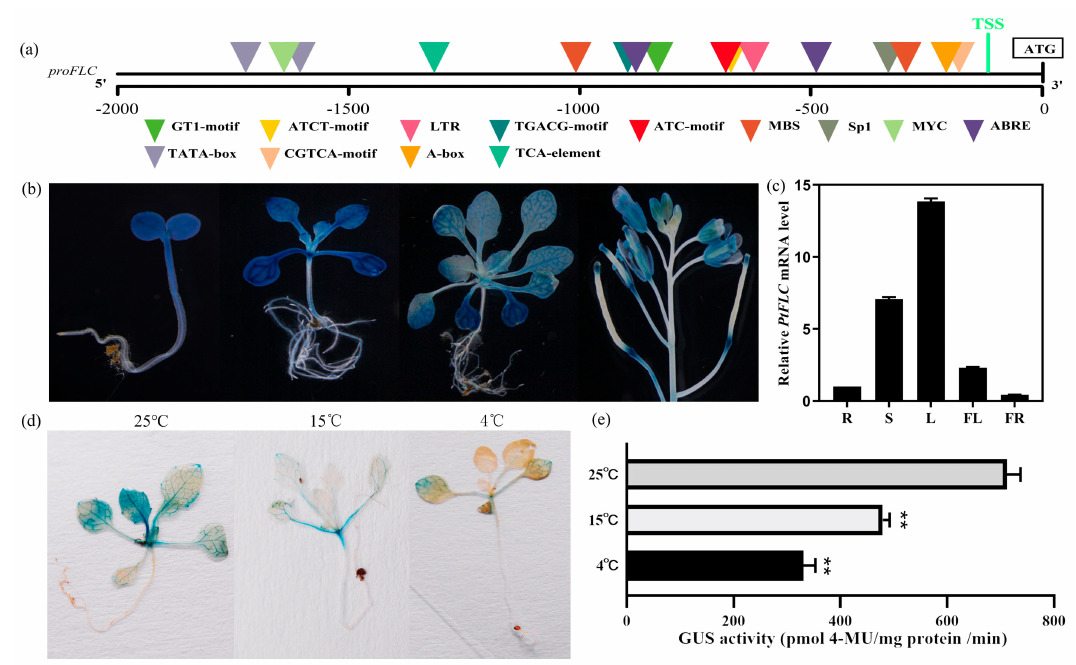
Figure 2. Promoter activity and spatial expression of PtFLC . ( a ) Schematic diagram of predicted cis -elements in proPtFLC . ( b ) Histochemical β -glucuronidase (GUS) staining of proPtFLC in di ff erent tissues of transgenic Arabidopsis under long-day conditions. ( c ) Relative expression of PtFLC in di ff erent tissues of trifoliate orange. R, roots; S, stems; L, leaves; FL, flowers at anthesis; FR, whole fruits at 30 days after flowering. ( d ) Analysis of GUS activity from proPtFLC in transgenic Arabidopsis by di ff erent temperature treatments (4, 15, and 25 ◦ C) under long-day conditions. ( e ) Relative GUS intensity from proPtFLC in transgenic Arabidopsis by di ff erent temperature treatments (4, 15, and 25 ◦ C) under long-day conditions. Asterisks indicate significant di ff erences (Student’s t -test): ** P <